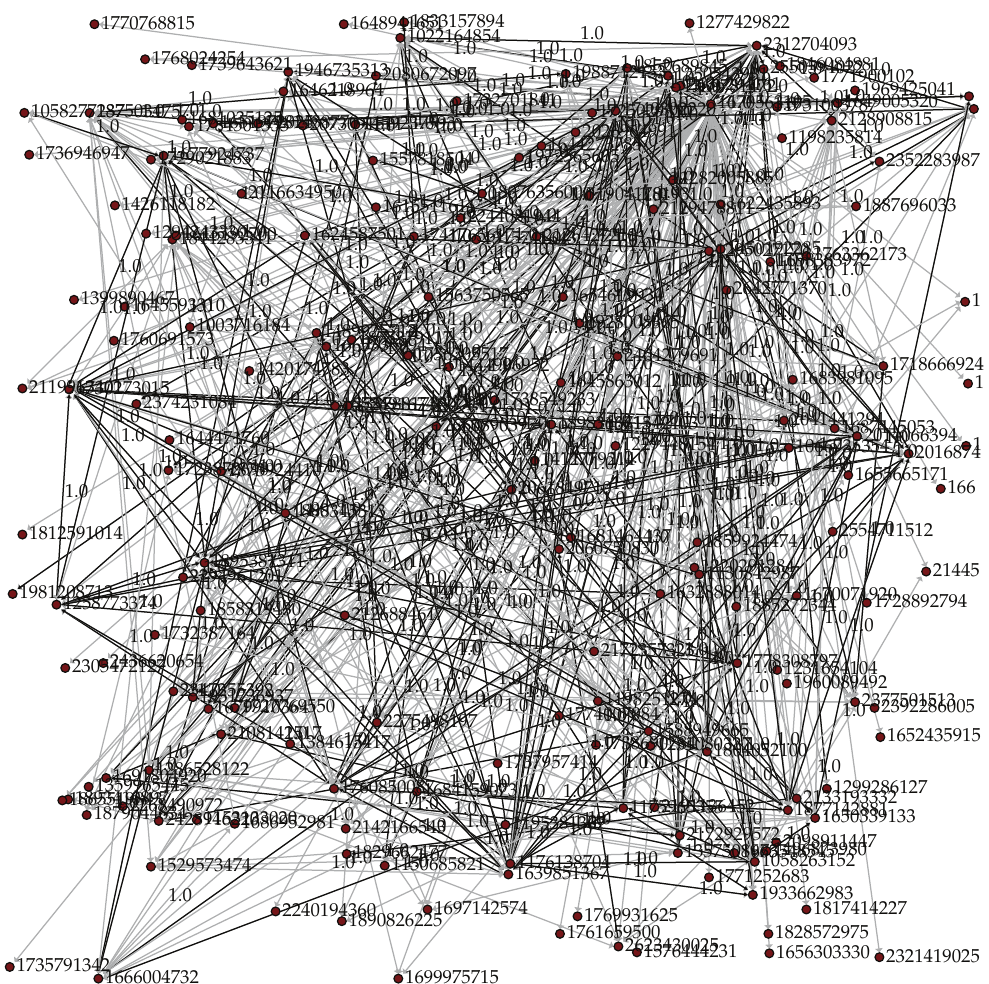
Figure 10: Real social network of our